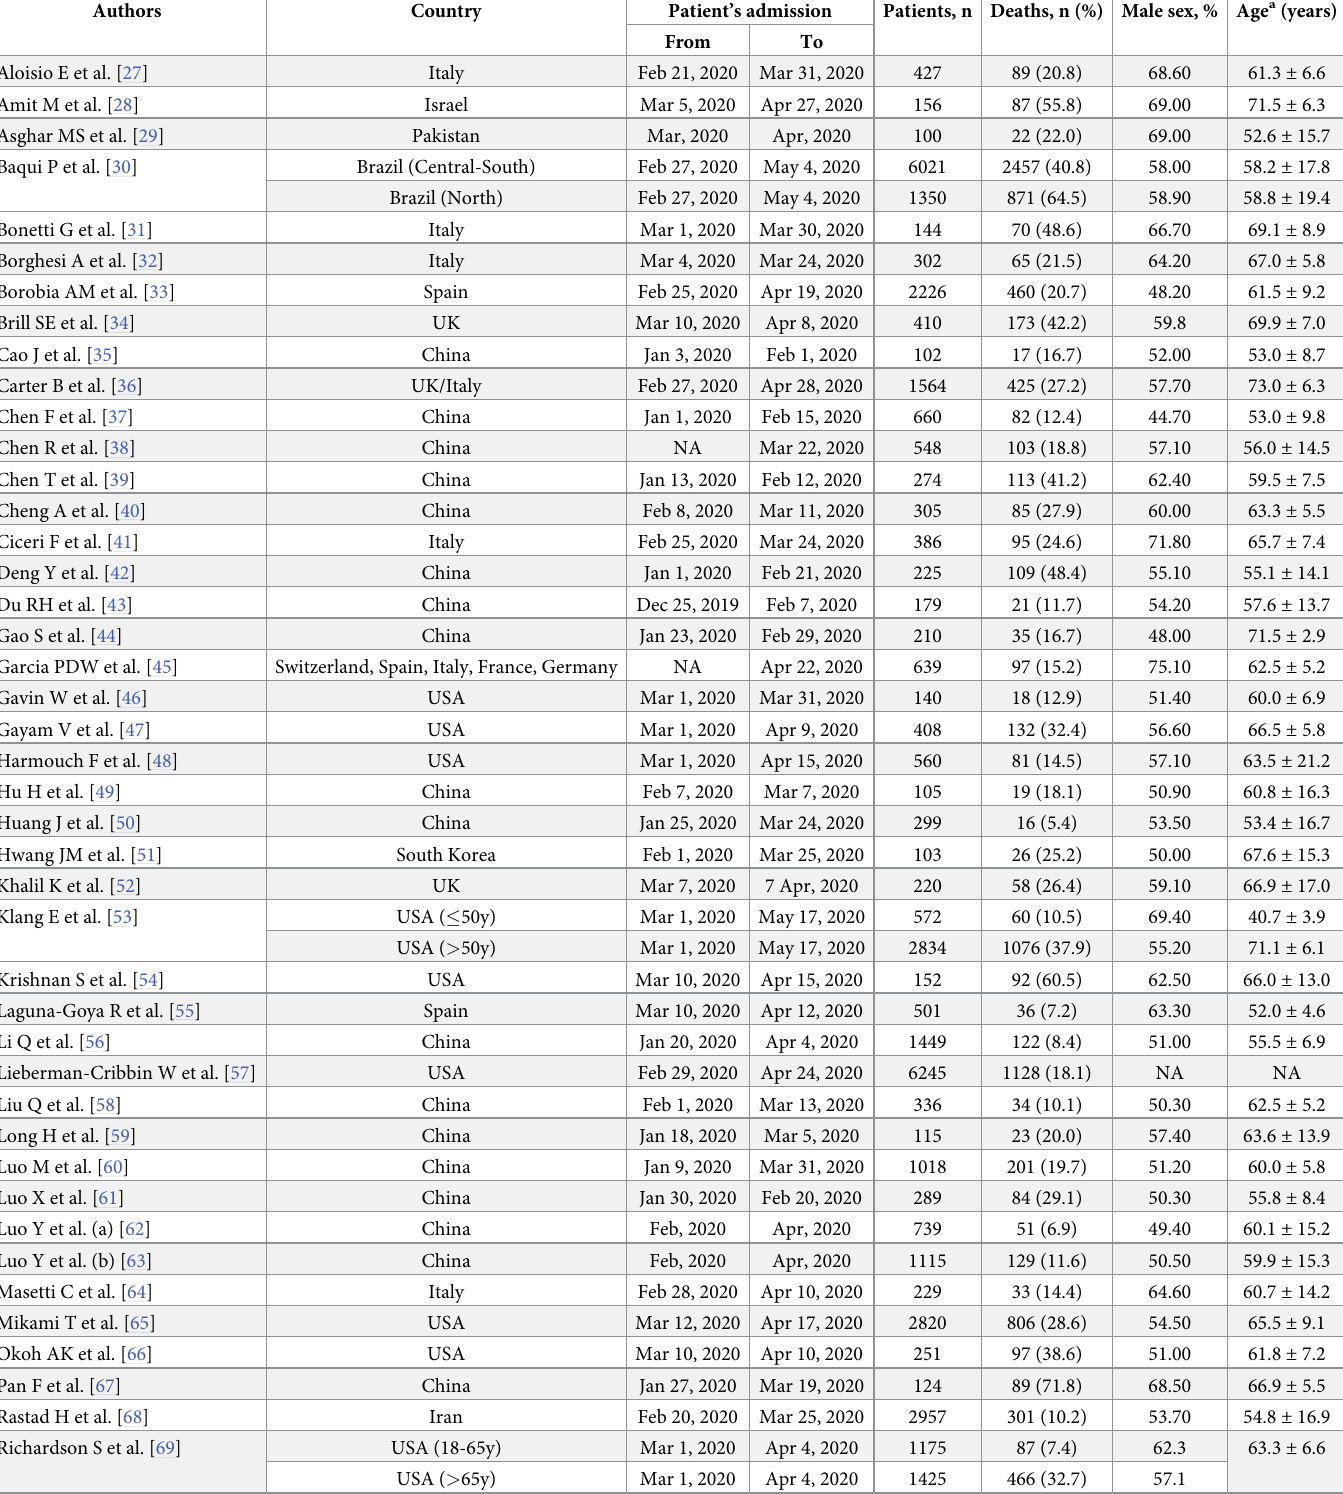
Table 1. Characteristics of the included